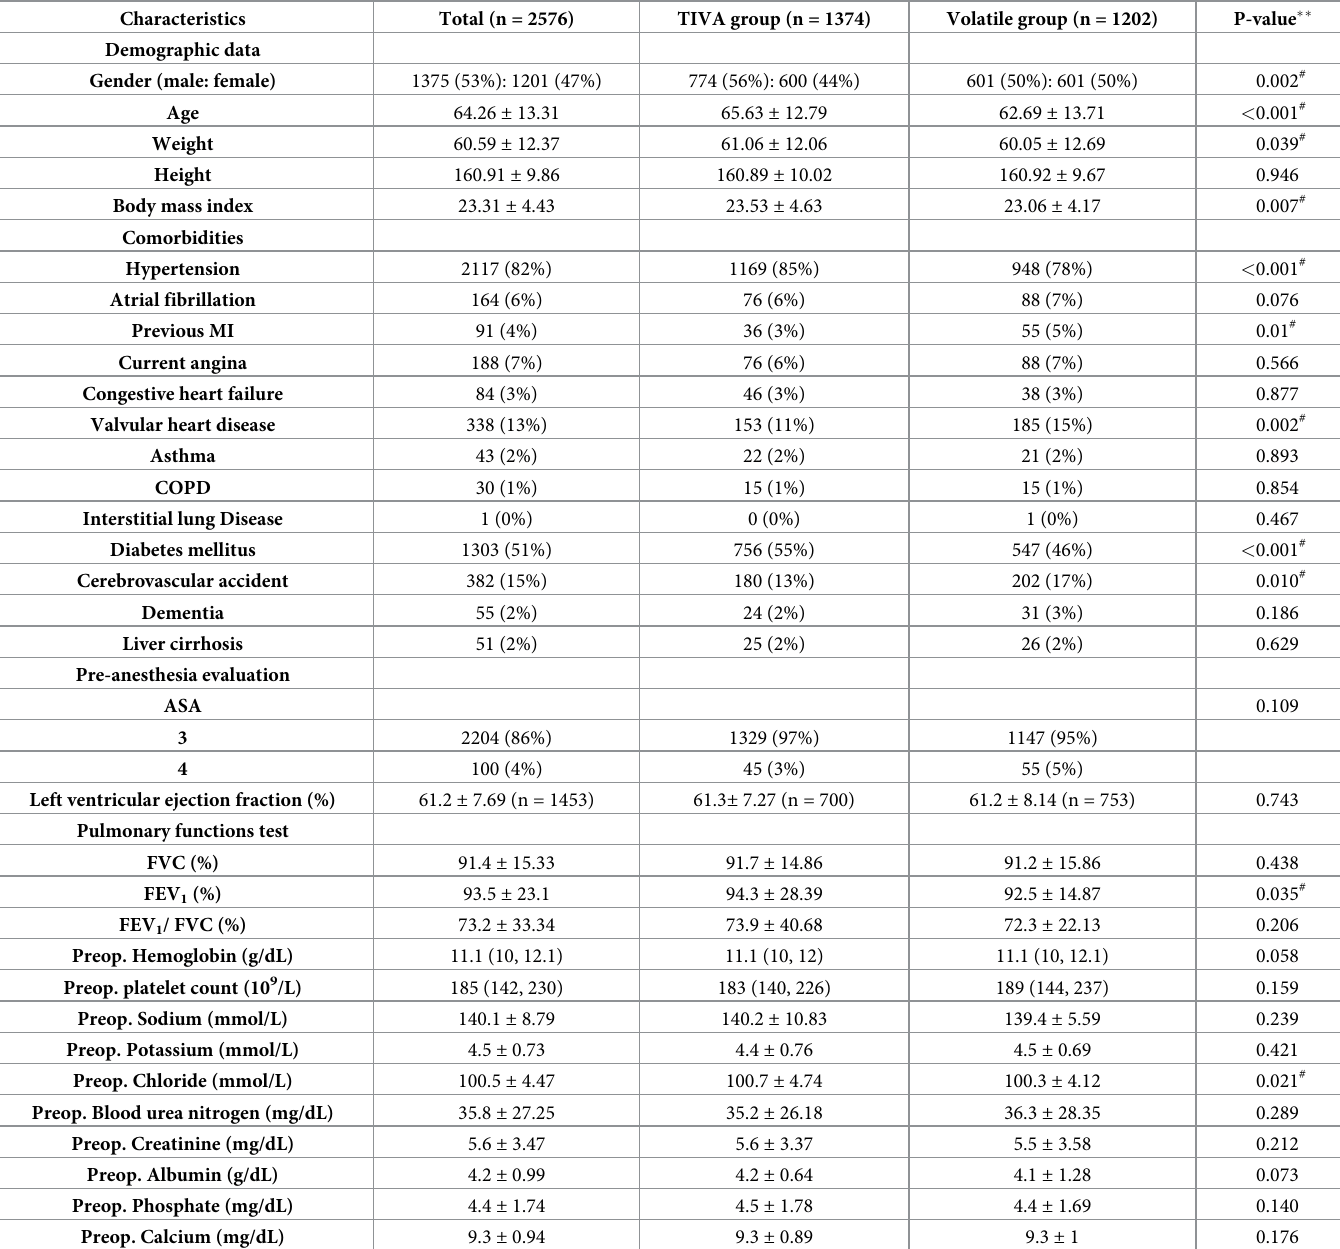
Table 1. Clinical patient